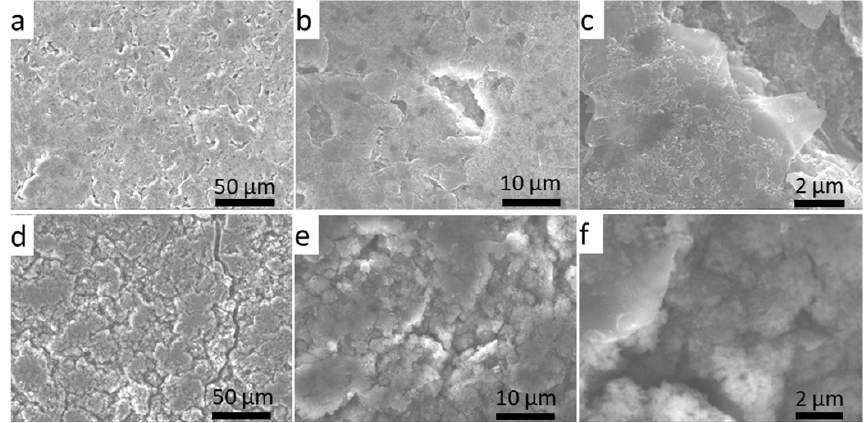
Figure 7. Morphology images of the Si/C composite electrodes. The formulation of the anodes was magE/nanoSi/C45/CMC/JSR3 = 82.9/9.2/2.5/3/2.4 (wt.%). ( a – c ) The SEM images of the anode before cycling. ( d – f ) The SEM images of the anode after